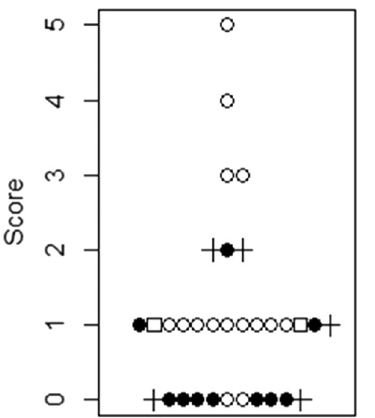
Fig. 12 Beeswarm plots representing the scores of the writing. ○ indicates students who could read the outline and main points, ● indicates those who could read the outline but not the main points, □ indicates those who could read the main points but not the outline, and outline nor the main